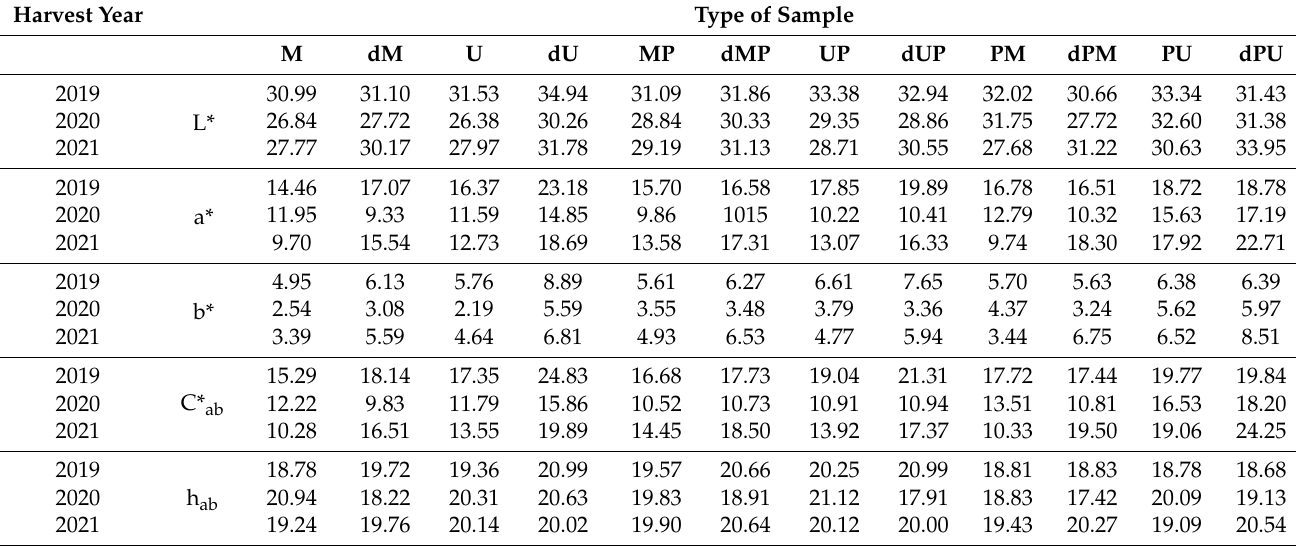
Table 1. Colorimetric data of the analyzed